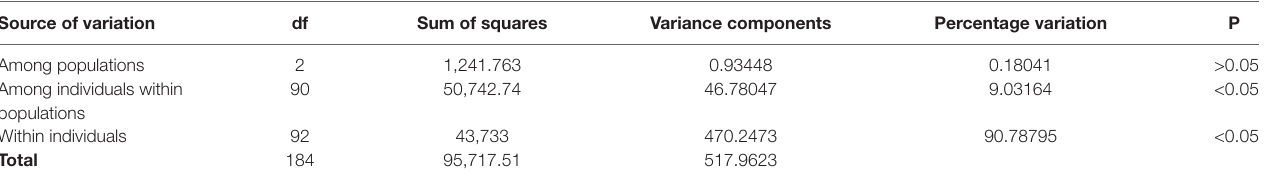
TABLE 2 | Analysis of molecular variance (AMOVA) showing genetic differentiation of 93 samples collected from Mombasa Marine Park, Bamburi, and Shimoni fishing grounds in coastal Kenya using DArT markers. Source of variation df Sum of squares Variance components Percentage variation P Among